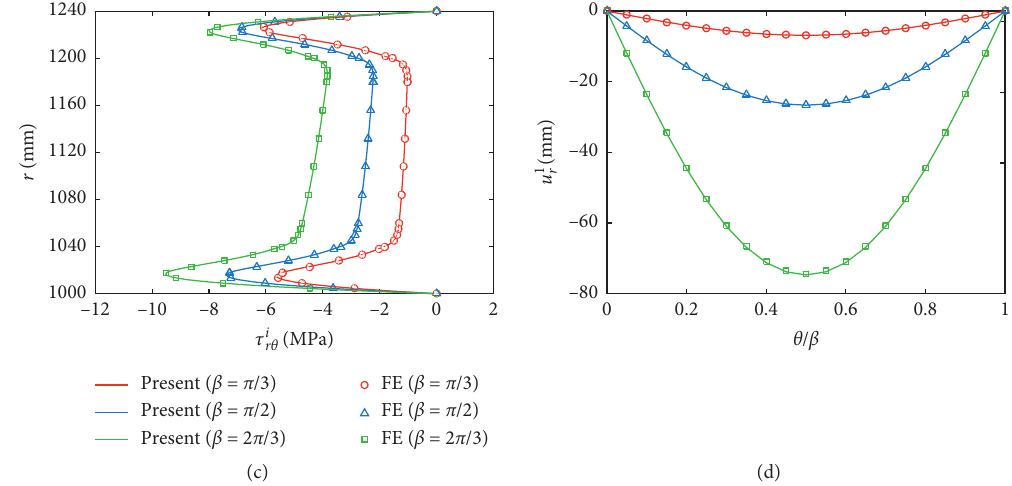
Figure 4: The comparison of stresses and deformations between the present solution and FE solution with different arch angles. (a) σ i θ � β /2. (b) σ i r at θ � β /2. (c) τ i at θ � 0. (d) u 1 r at r � R 1 . r θ